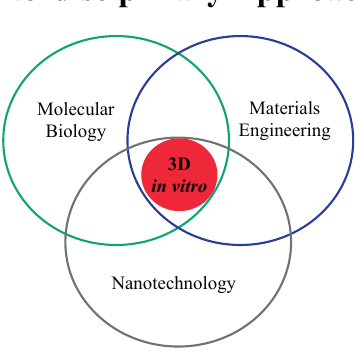
Figure 1. Interdisciplinary approach of 3D in vitro